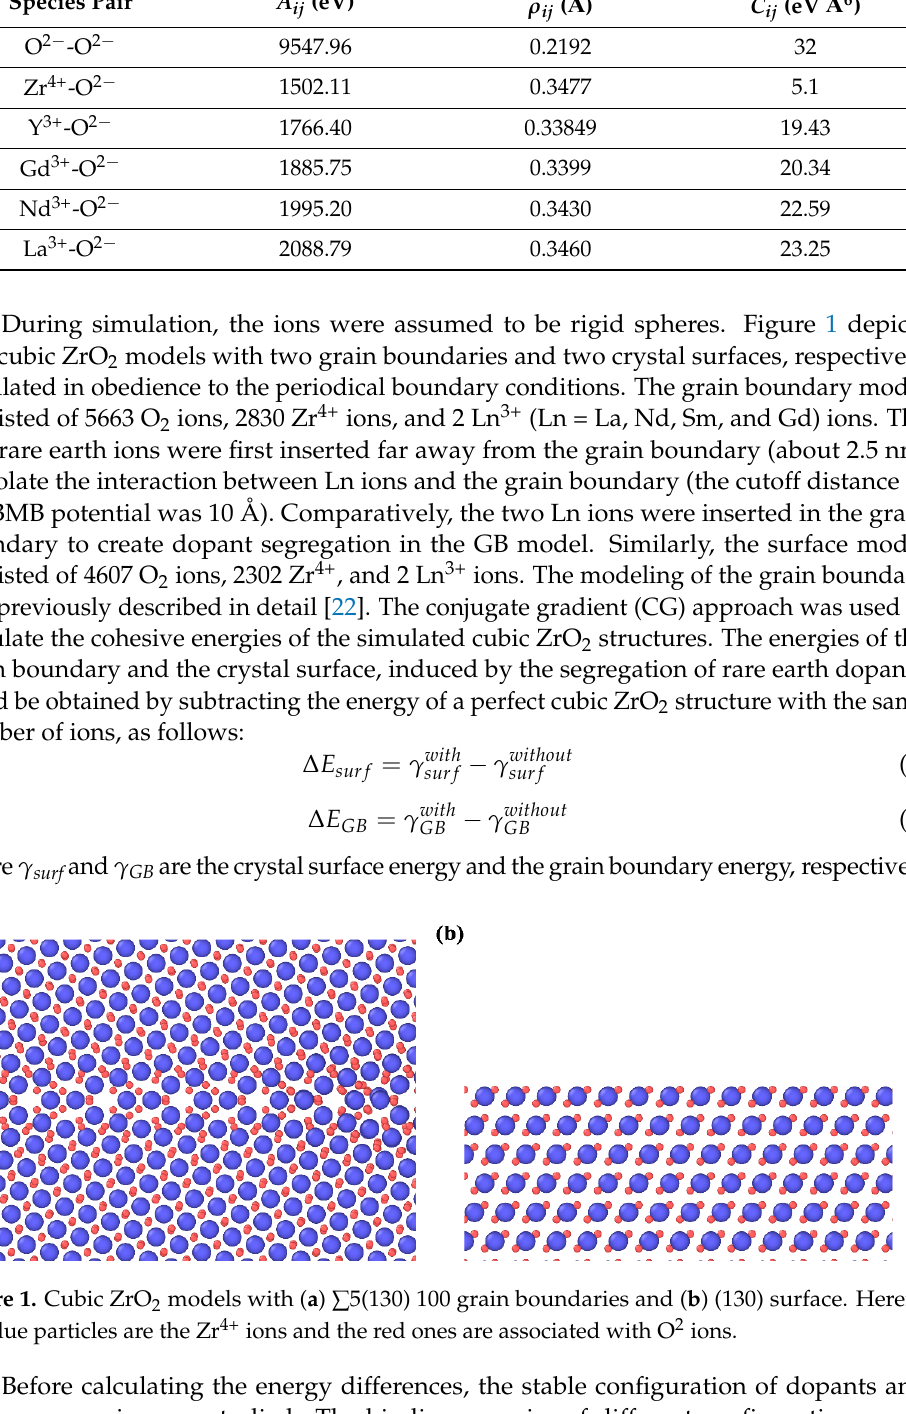
Table 1. Potential parameters of A , C , and ρ in Equation (3).